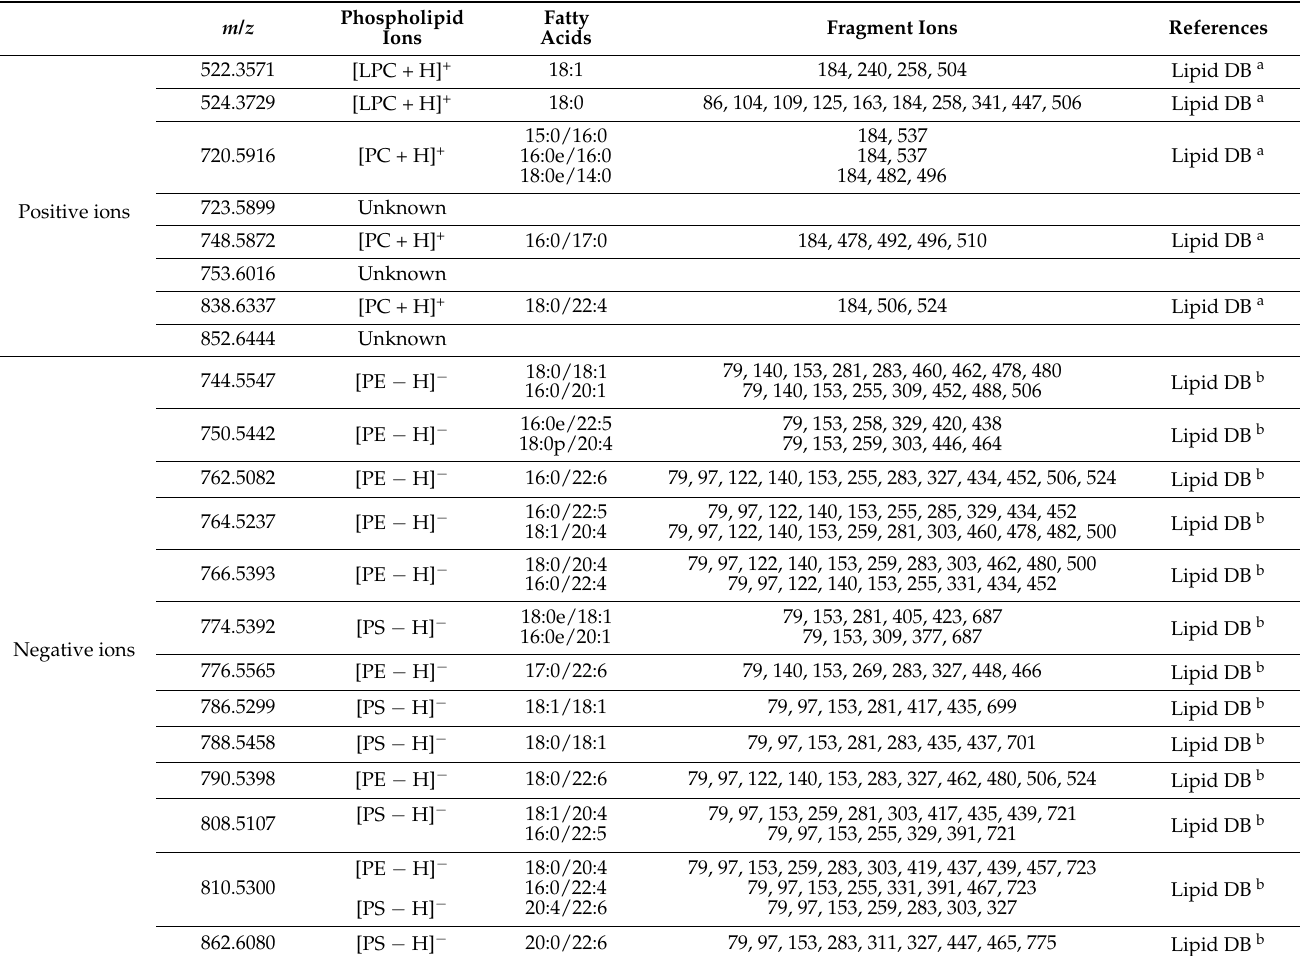
Table 1. Identification of phospholipid ions detected in brain tissue of control and valproic acid- induced autism mice. PUFAs are marked in red.